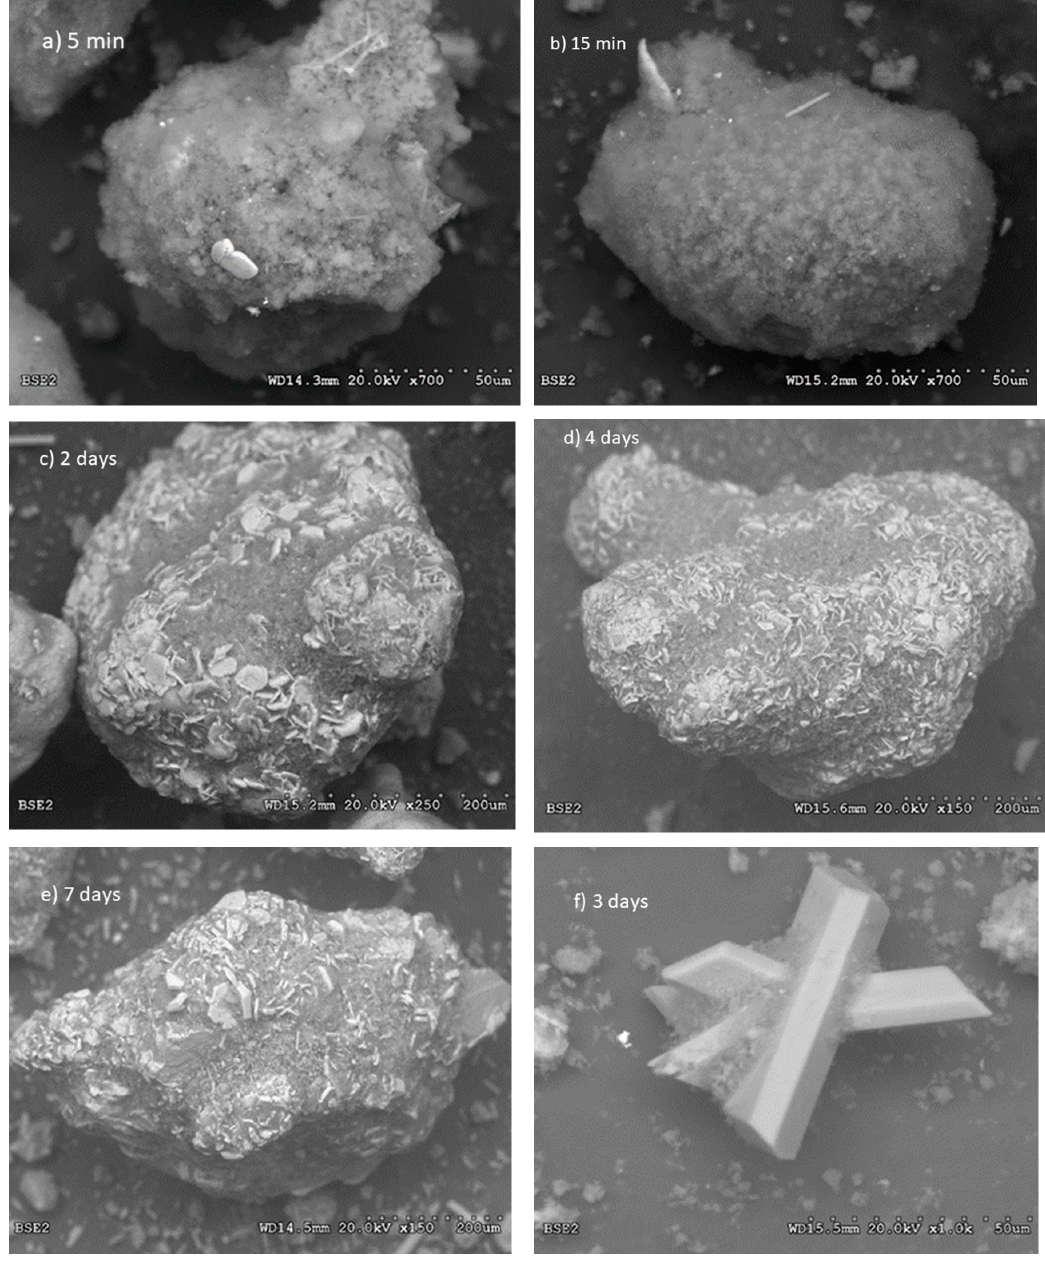
Figure 17. A selection of images from the SEM investigation as a function of time for lime